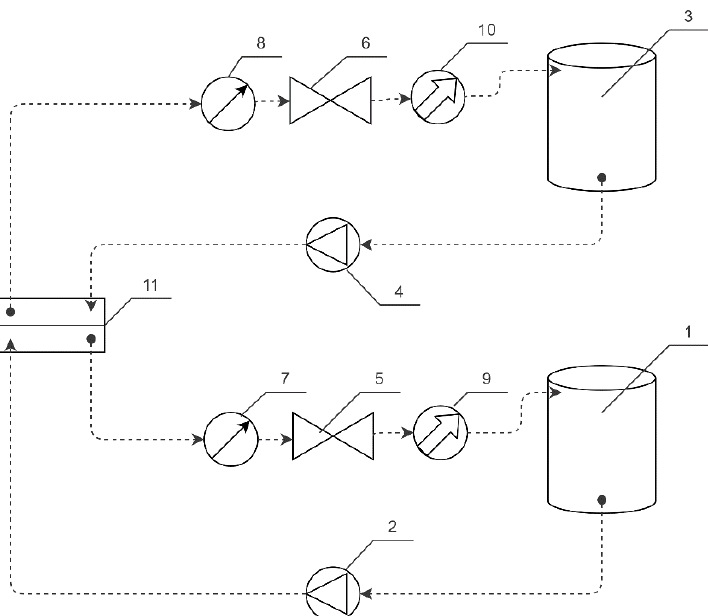
Figure 1. Diagram of the SEPA FO CELL installation (1—feed solution tank, 2—feed solution pump, 3—draw solution tank, 4—draw solution pump, 5—concentrate control valve, 6—draw solution control valve, 7—concentrate pressure gauge, 8—draw solution pressure gauge, 9—concentrate flow meter, 10—draw solution flow meter, 11—SEPA FO cell).